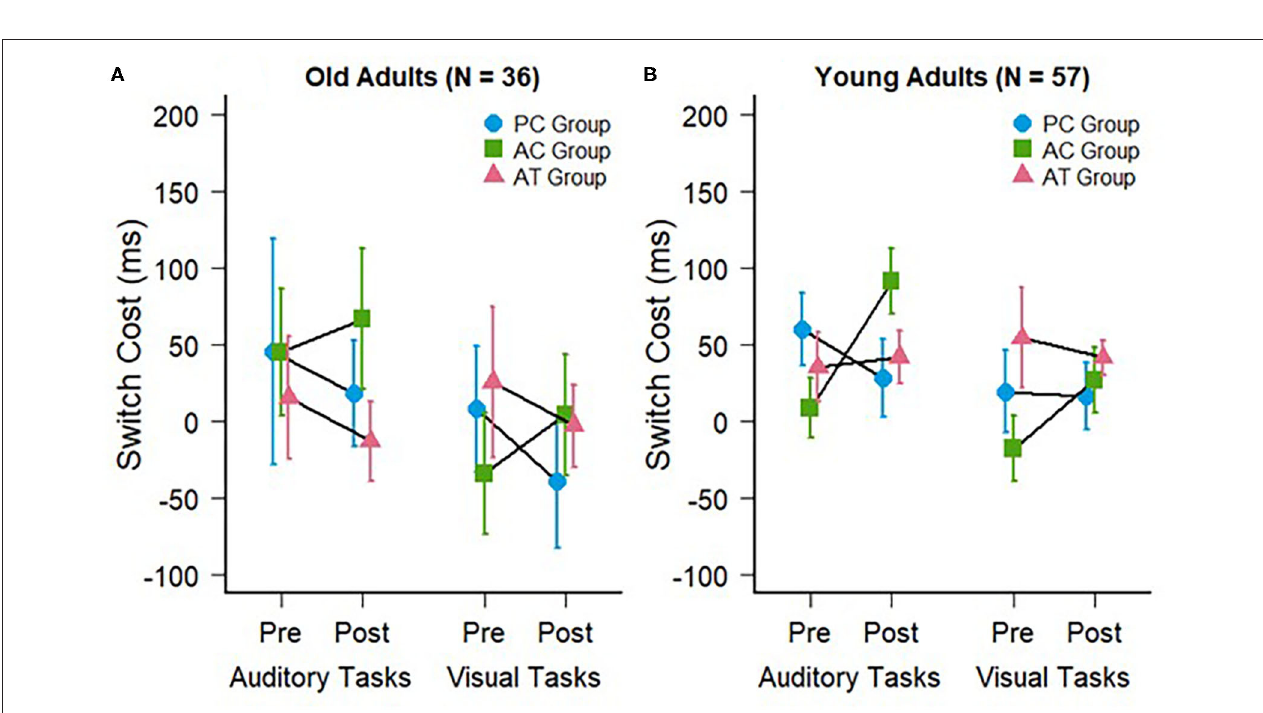
FIGURE 3 | Switch costs during auditory (trained) and visual (untrained) task switching at pre- and post-test for (A) the old adults of the present study and (B) the young adults of a previous study (Kattner et al., 2019). Error bars depict standard errors of the mean.